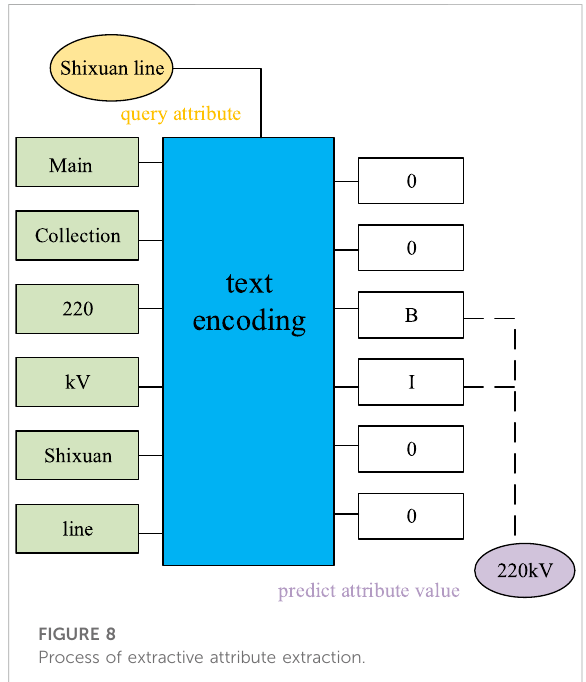
FIGURE 8 Process of extractive attribute